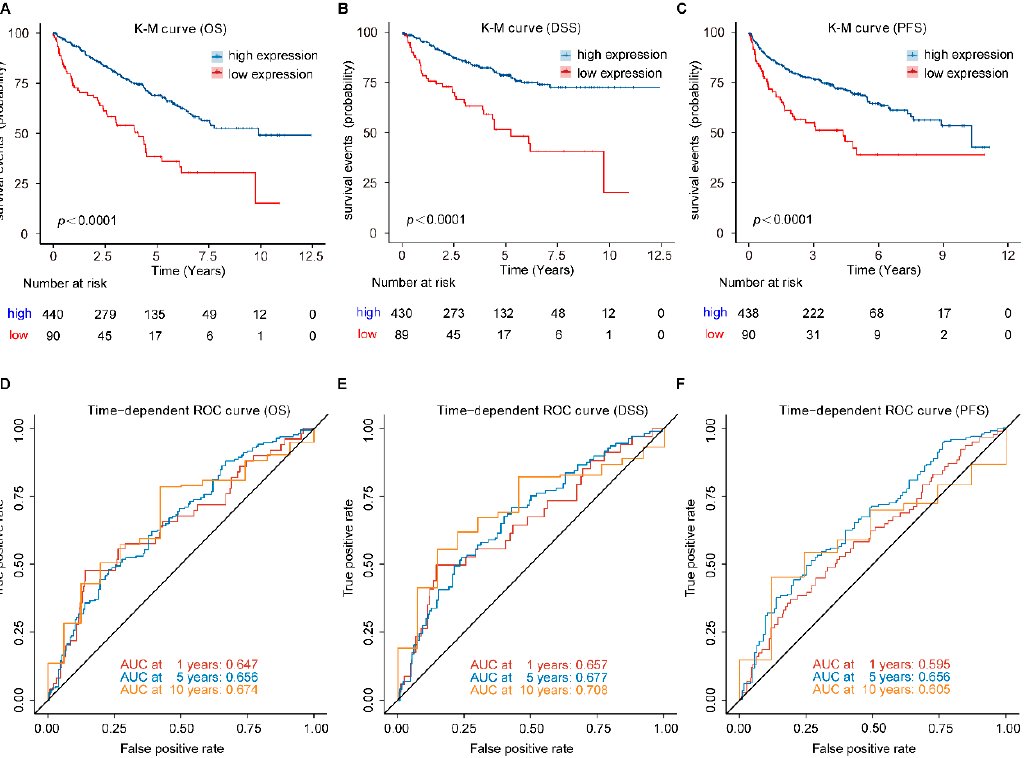
Figure 4. Prognostic analysis of FDX1 in ccRCC patients. ( A ) OS, ( B ) DSS, and ( C ) PFS, was significantly higher in the high-expression group than in the low-expression group in ccRCC patients; ( D – F ) Time-dependent ROC curve analysis of FDX1 . OS, overall survival; DSS, disease-specific survival; PFS, progression-free survival.